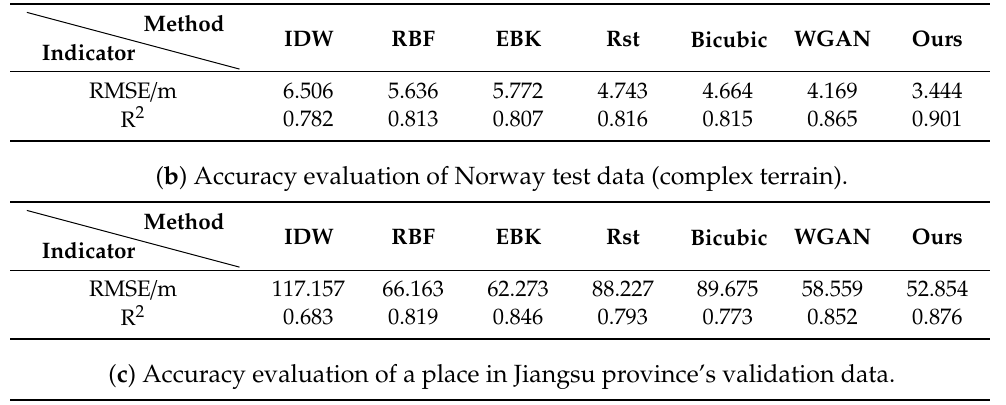
Table 2. Accuracy evaluation of filling